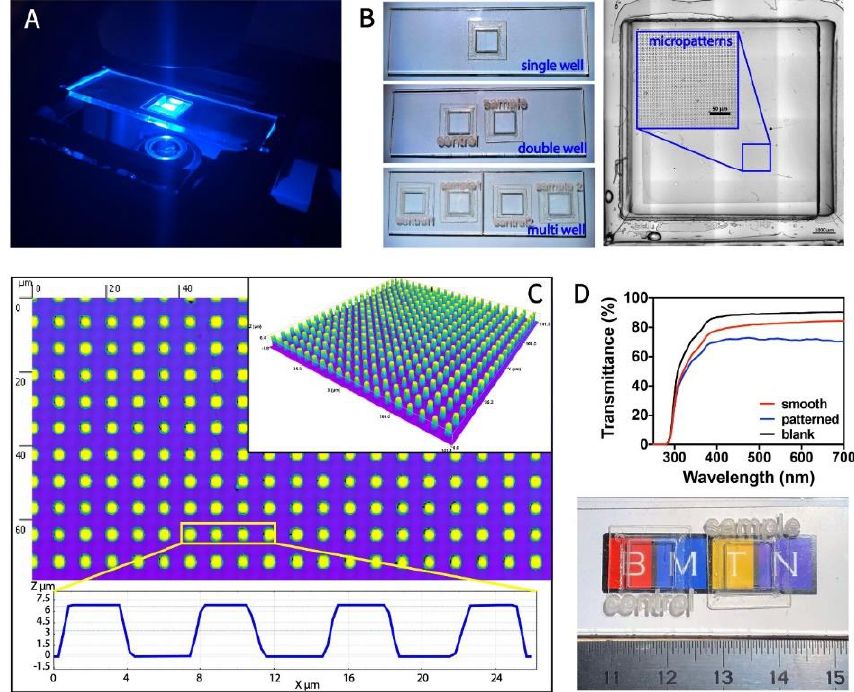
Figure 1. Images and characterization of transparent, micropillar-bottom culture chip (Ch-Pattern) . ( A ) CLSM image of the Ch-Pattern. ( B ) Organization of the single-, double-, and multi-well chips for the single and simultaneous imaging for selected applications ( left panel ); stitched phase-contrast image of the chip ( right panel ). ( C ) Surface profile of the micropatterns obtained using a profilometer. ( D ) Transparency of the PMMA micropatterned substrate. The transmittance of the smooth and patterned substrates was measured against blank.